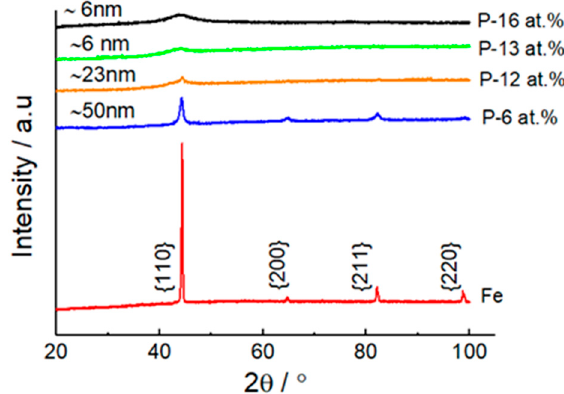
Figure 6. X-ray diffraction patterns of Fe-P alloys with varying P contents. The coatings were electrodeposited at 30 mA cm − 2 and 60 °C from electrolytes containing various Gly concentration: 0 M (Fe-6 at.% P), 0.11 M (Fe-12 at.% P), 0.21 M (Fe-13 at.% P), and 0.64 M (Fe-16 at.% P).